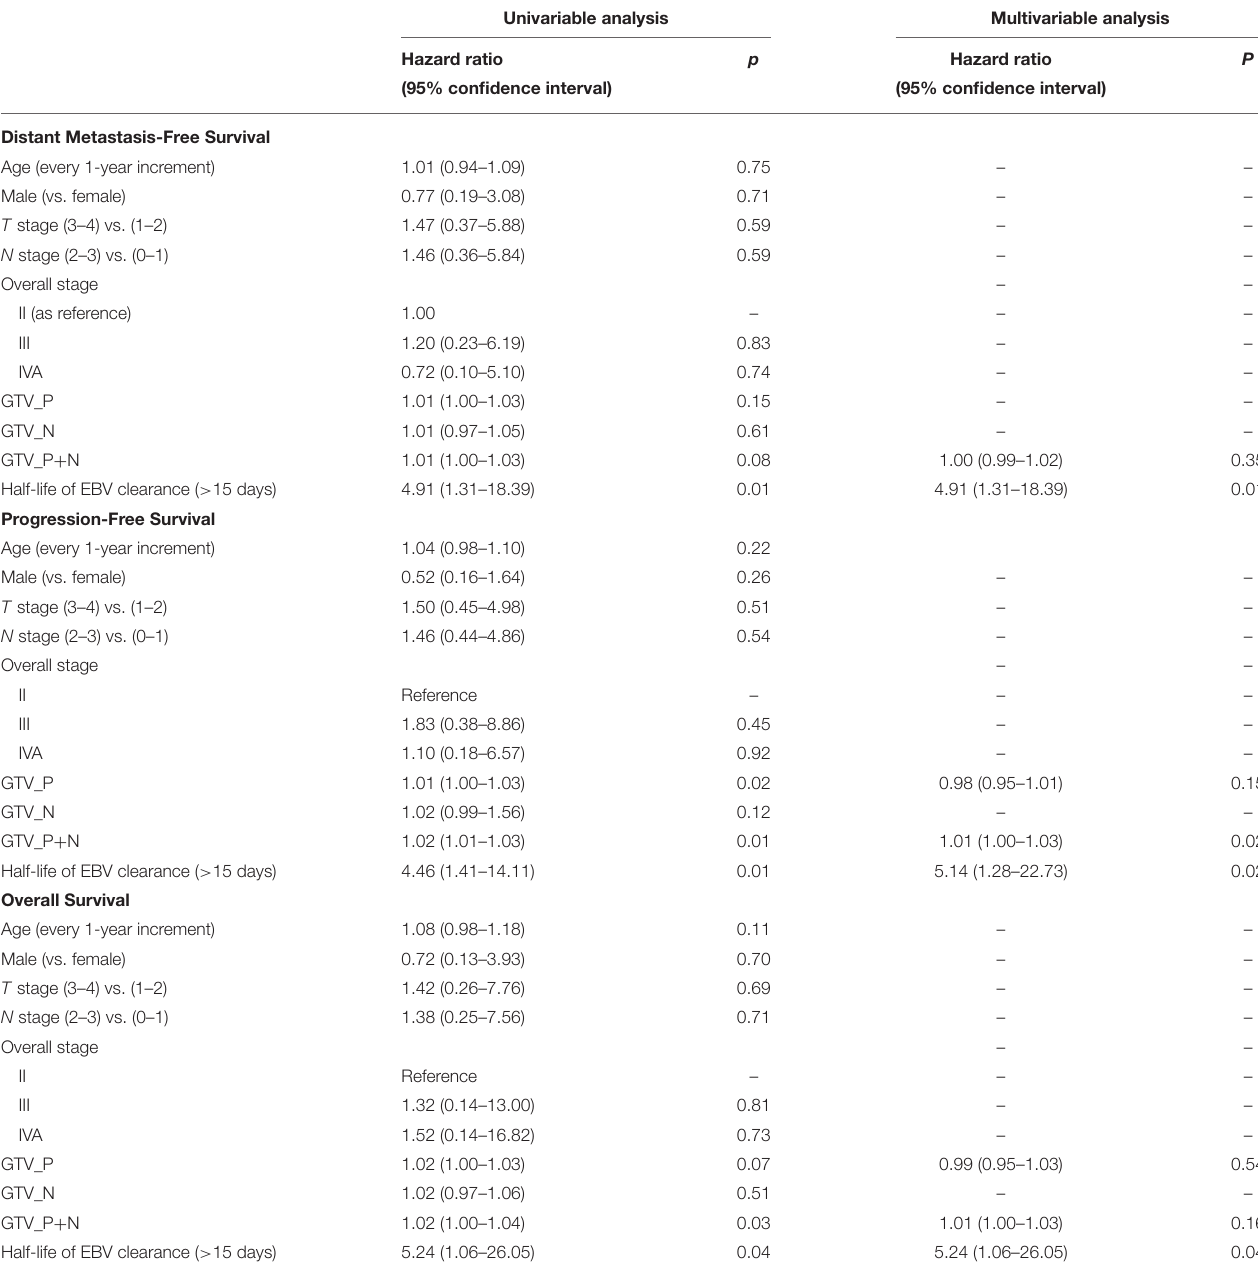
TABLE 4 | Univariable and multivariable analyses of variables prognostic of distant metastasis-free survival, progression-free survival, and overall survival. Univariable analysis Multivariable analysis Hazard ratio p Hazard